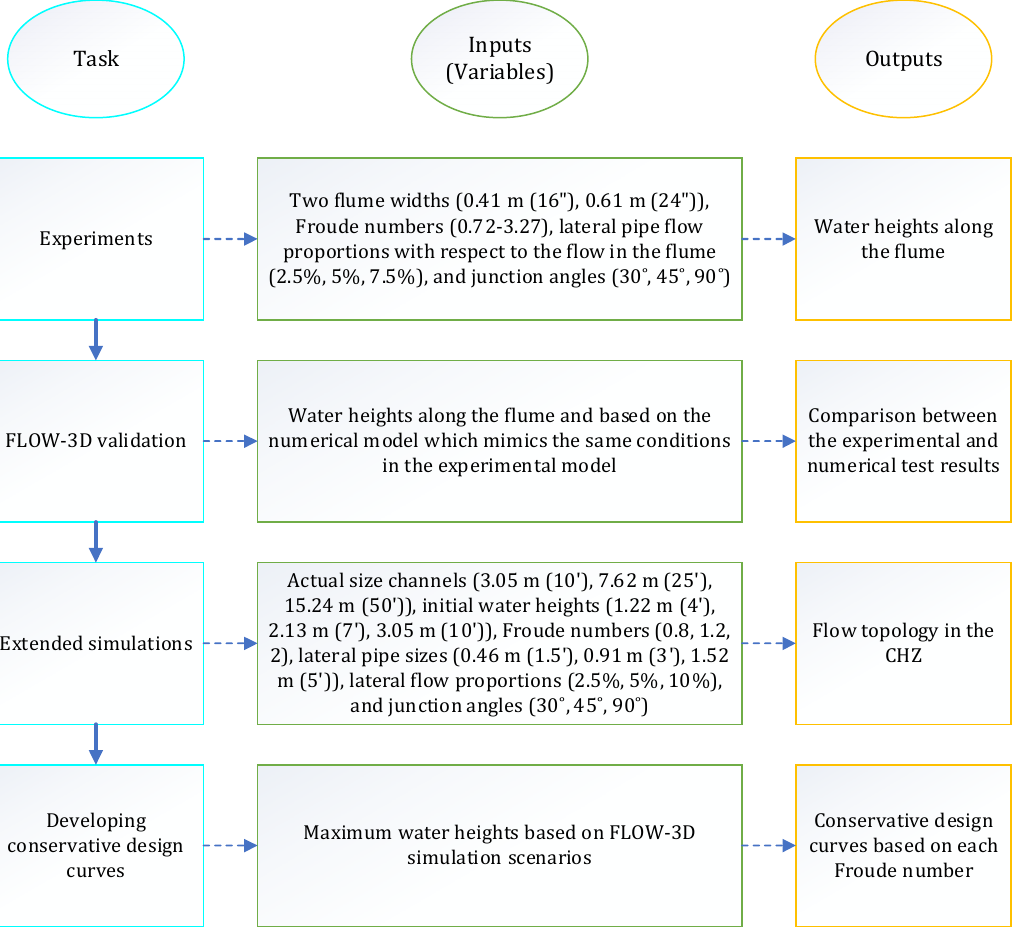
Figure 2. The flow chart of this study.